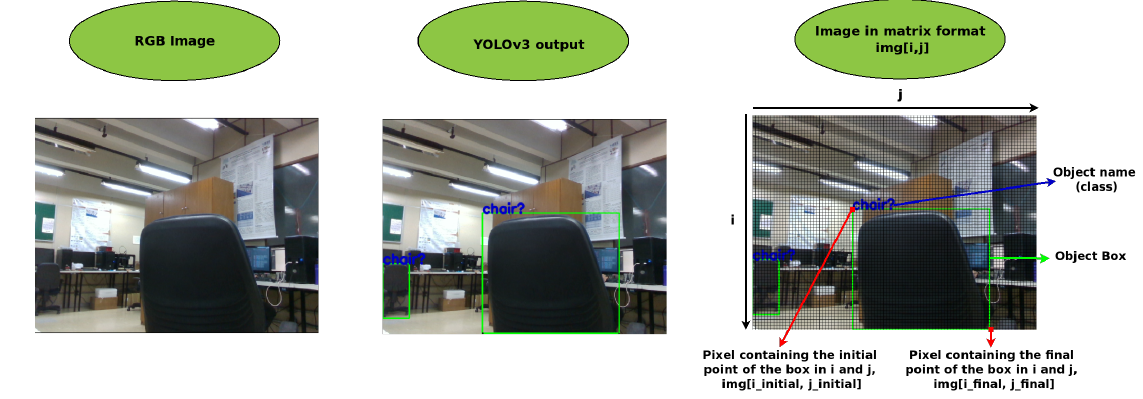
Figure 4. Extraction of the tokens from the